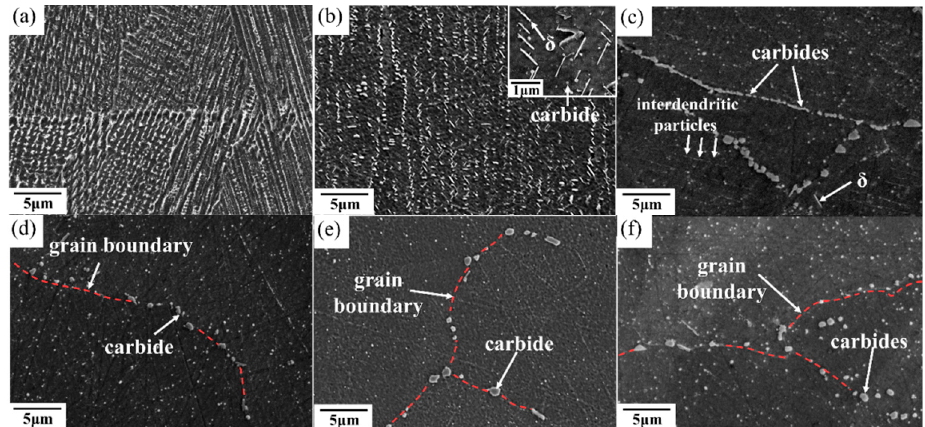
Figure 4. Scanning electron microscope images of ( a ) as-built, ( b ) STA-980 ◦ C, ( c ) STA-1045 ◦ C, ( d ) STA-1065 ◦ C, ( e ) STA-1120 ◦ C, and ( f ) STA-1180 ◦ C/1 h specimens. Table 4. TEM-EDS results of the precipitate (atom %).